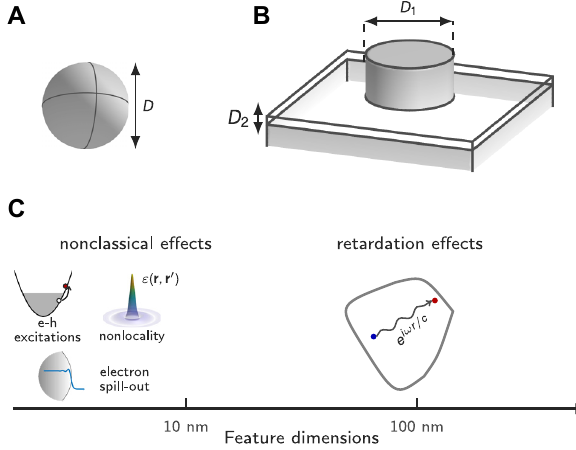
Figure 1: Nanoplasmonic particles, and their associated retardation and nonclassical